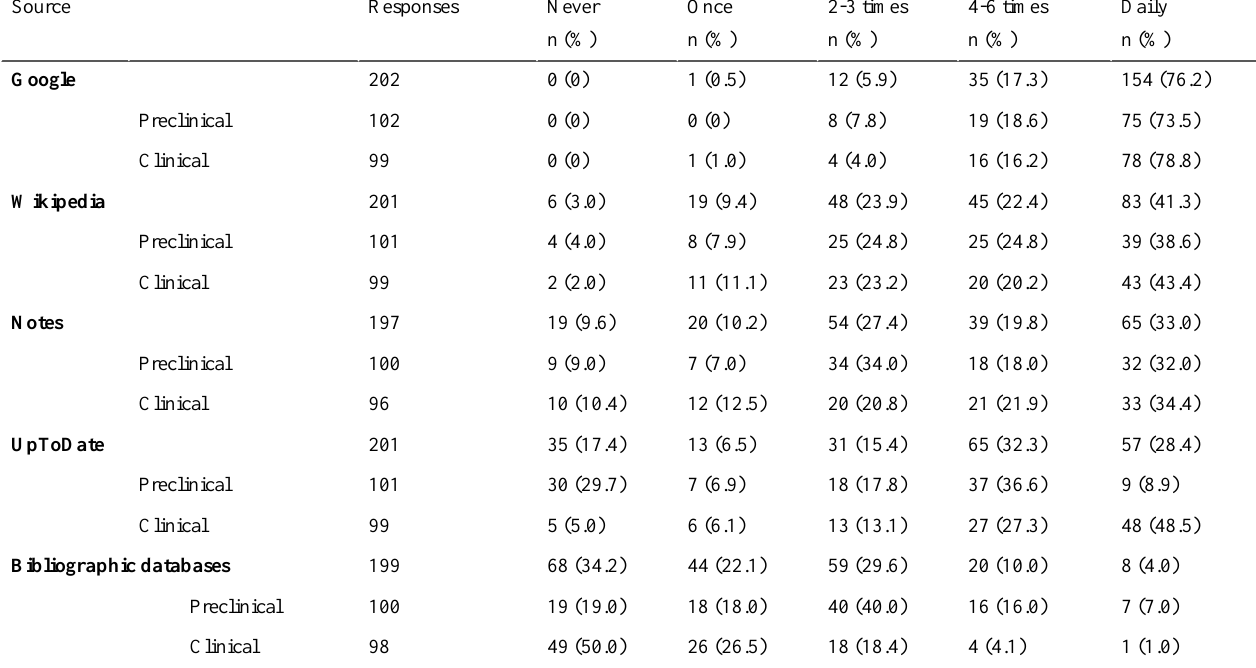
Table 1. Preclinical and clinical student use of resources during the previous 7